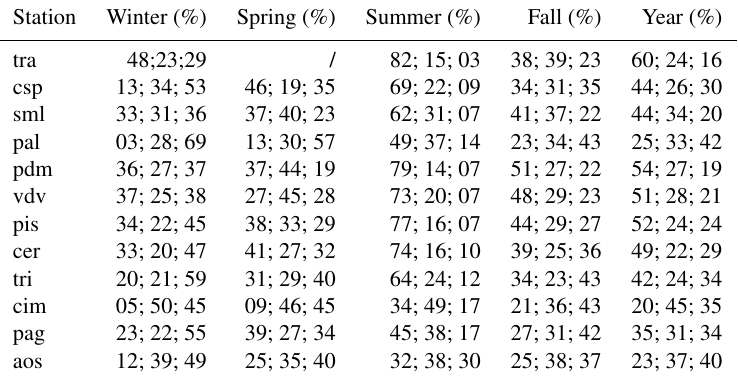
Table 3. Percentage of data in clear, contaminated, and overcast conditions for all stations and seasons, as well as for the whole year, estimated by CPP (Sect.